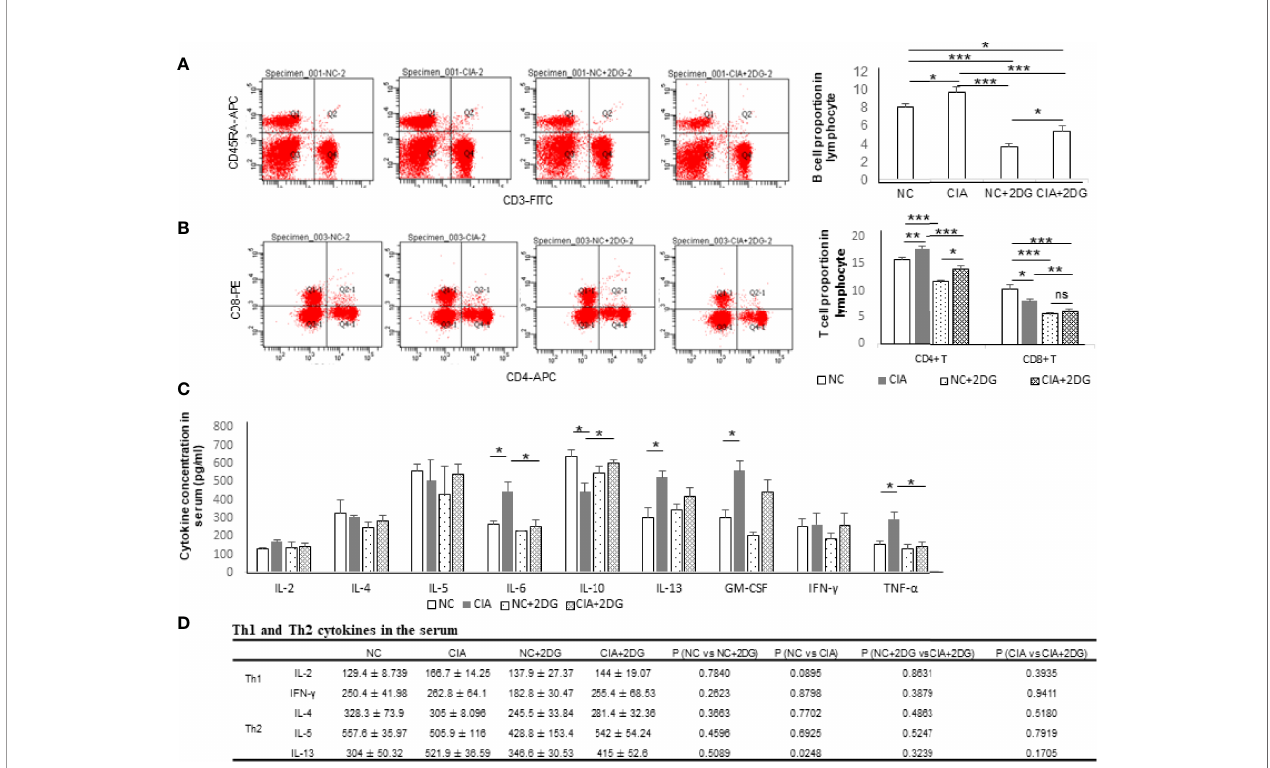
FIGURE 2 | The immune effect of 2-DG treatment on CIA rats. (A) B cell proportion in peripheral blood of the CIA rats treated with PBS (n=6) or 2-DG (n=6). The healthy rats (NC) treated with PBS (n=6) or 2-DG (n=6) were used as controls. (B) CD4+ T cell and CD8+ T cell proportions in peripheral blood of the rats. (C) Proin fl ammatory cytokine levels in peripheral blood of the rats. (D) Th1 (IFN- g and IL-2) and Th2 (IL-4, IL-5 and IL-13)-related cytokine levels in the rats. *p < 0.05, **p < 0.01, and ***p < 0.001.